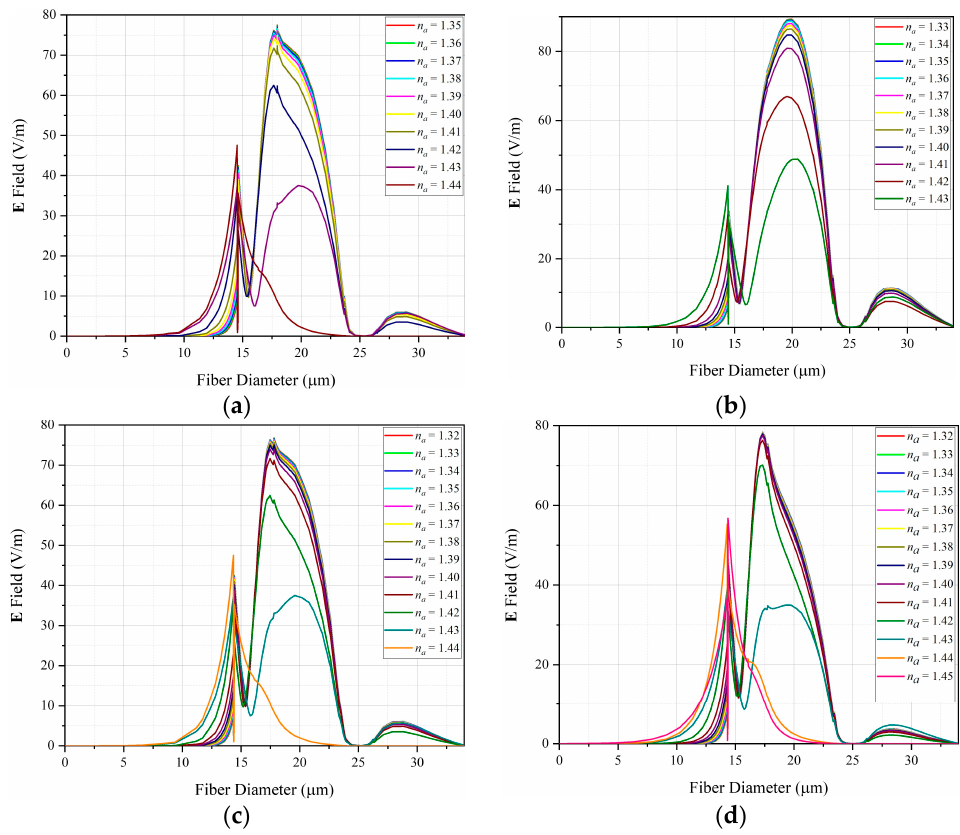
Figure 7. One-dimensional E -field for sensor with defect doped with GeO 2 : ( a ) 4.1%; ( b ) 6.3; ( c ) 13.5%; ( d ) 19.3% .